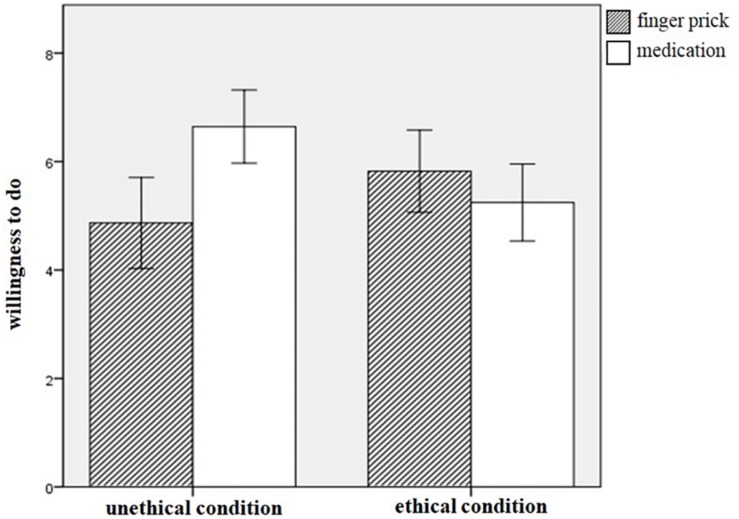
Willingness to prick a finger with a needle and to take a strong dose of medicine to treat indigestion across two conditions in Study 1. Error bars represent 95% CI.